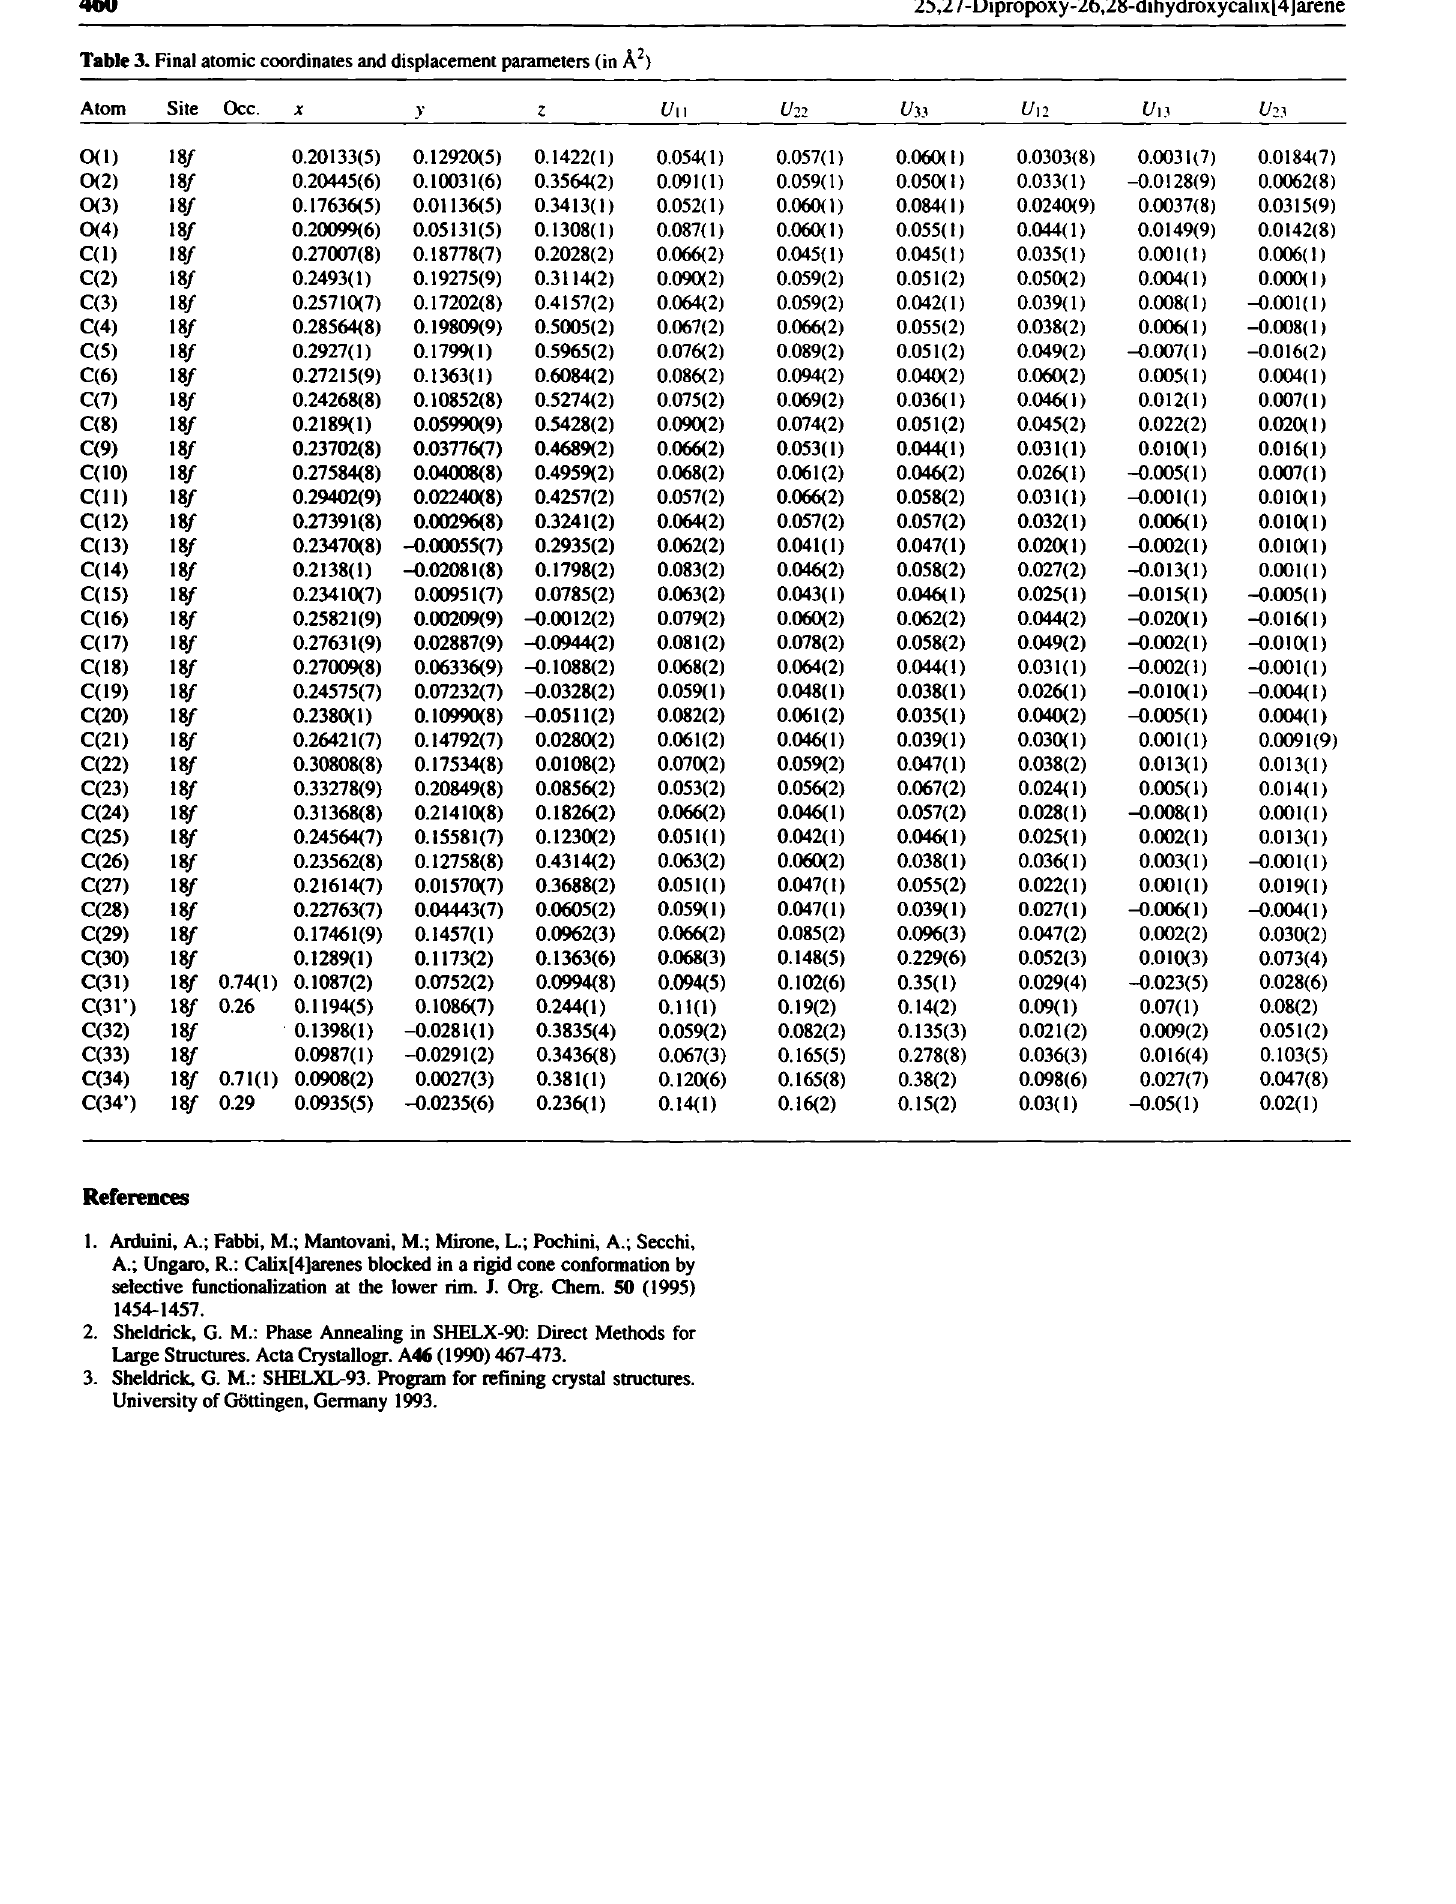
Table 3. Final atomic coordinates and displacement parameters (in Â 2 ) Atom Site